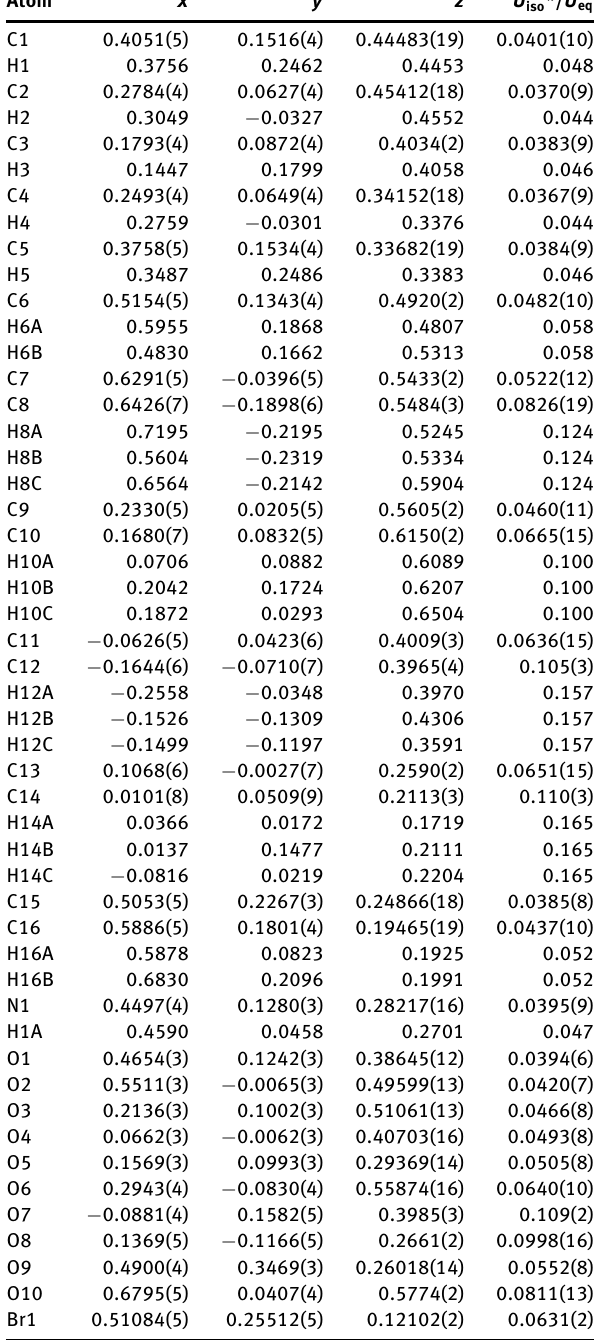
Table 2: Fractional atomic coordinates and isotropic or equivalent isotropic displacement parameters (Å 2